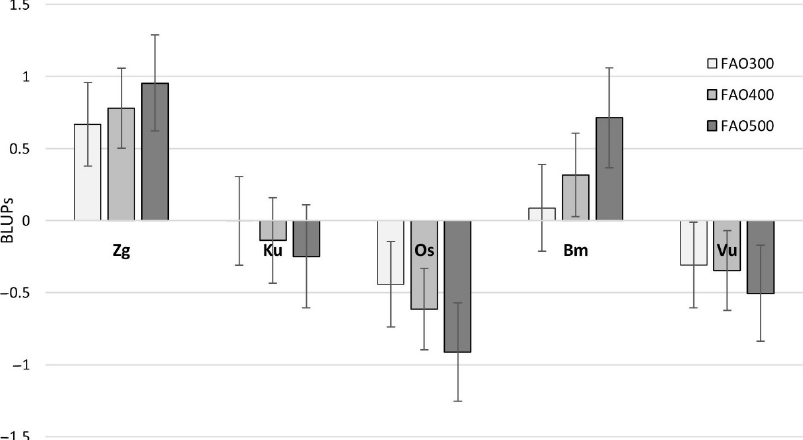
Figure 3. Unadjusted means for grain yield with corresponding standard errors in VCU trials across five locations in maize genotypes belonging to three maturity groups FAO 300, FAO 400, and FAO 500.